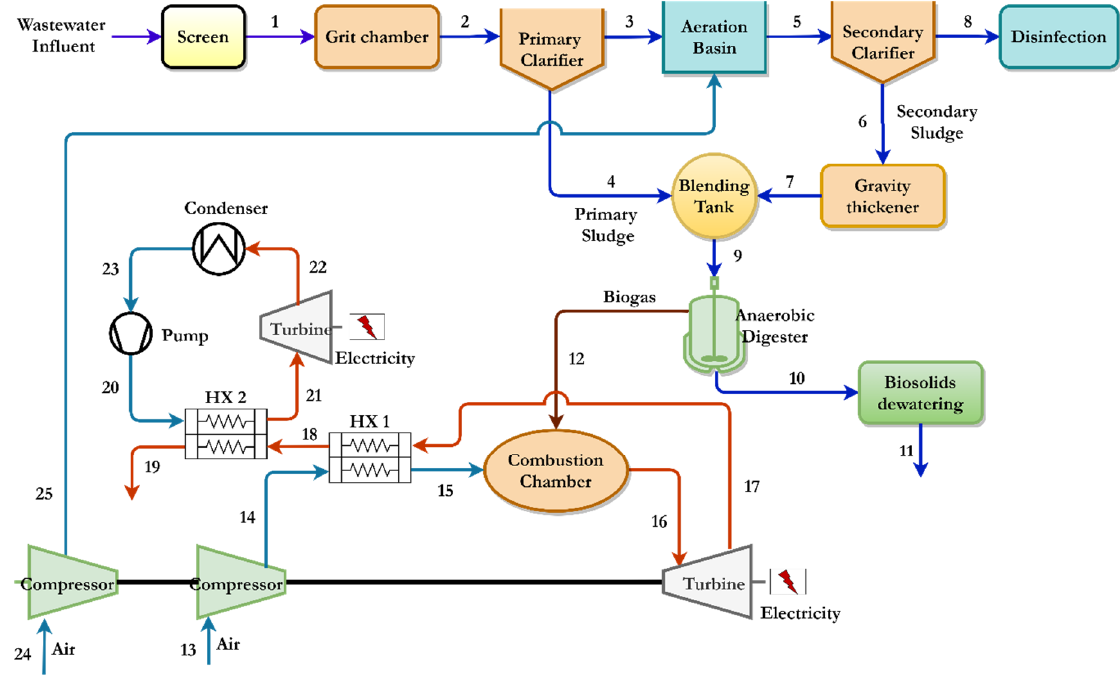
Figure 1. Proposed System.